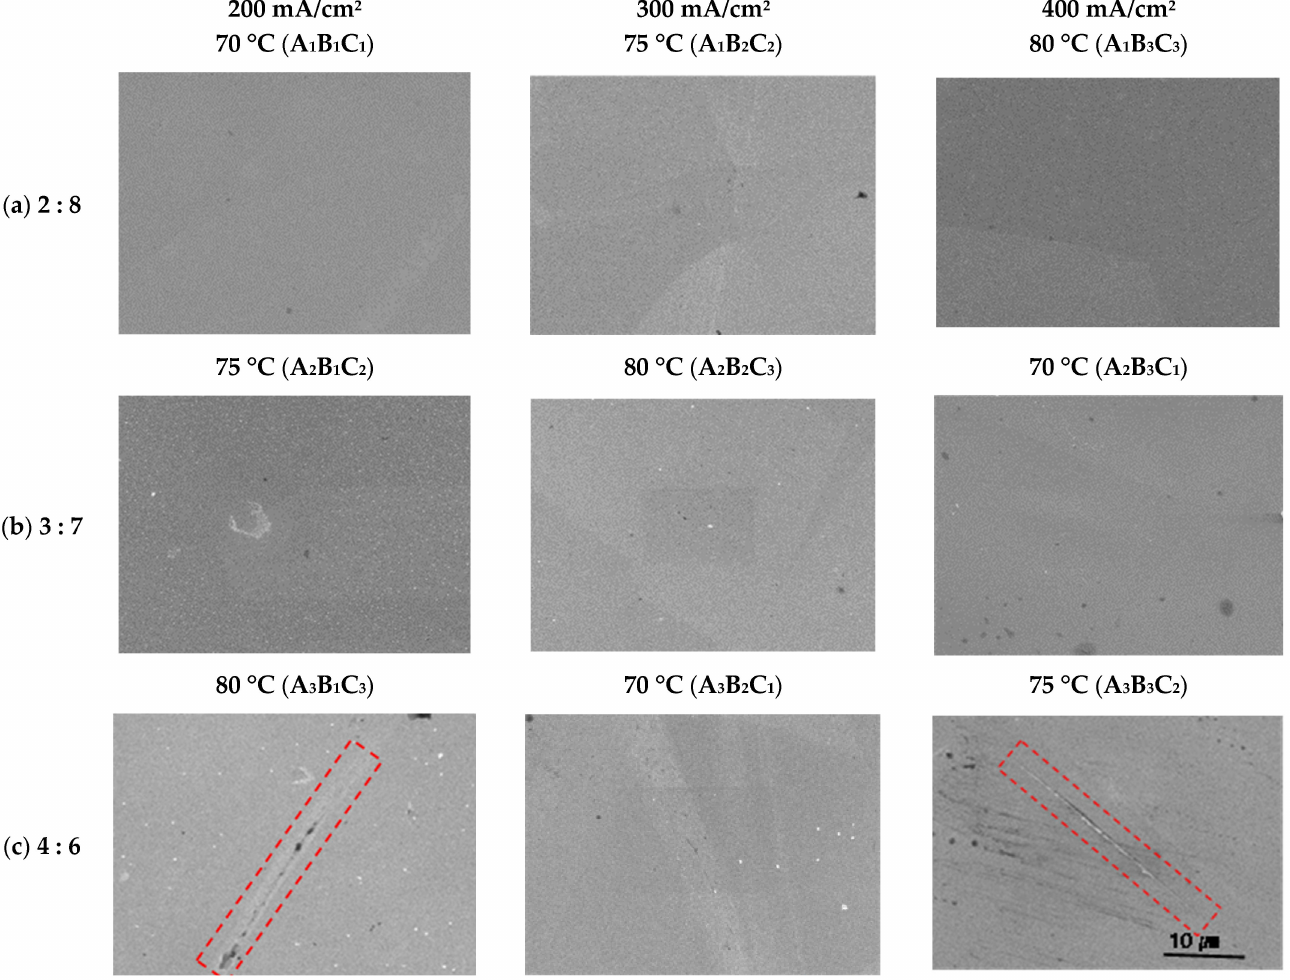
Figure 4. Surface morphologies after electropolishing in an electrolyte containing sulfuric acid (95 wt%) and phosphoric acid (85 wt%). A 3 B 1 C 3 , A 3 B 3 C 2 : damaged, the rest: smooth and